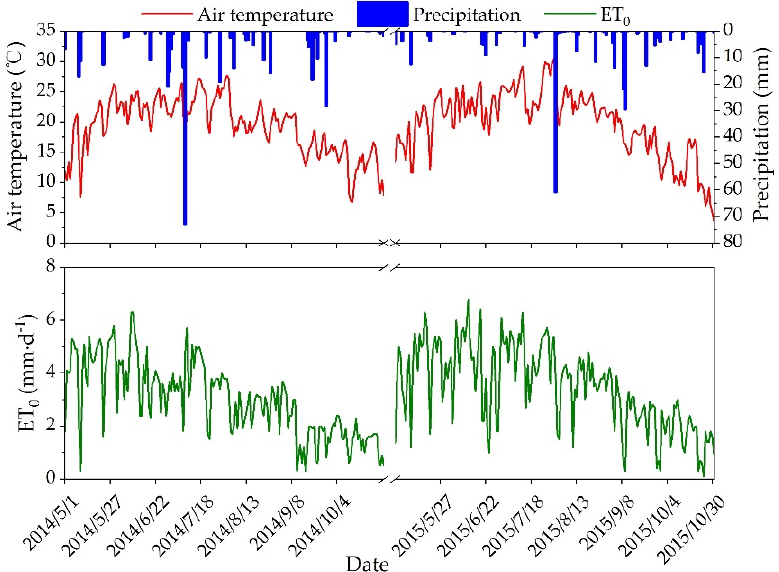
Figure 2. Precipitation, air temperature, and daily reference crop evapotranspiration (ET 0 ) during the 2014 and 2015 growing seasons.